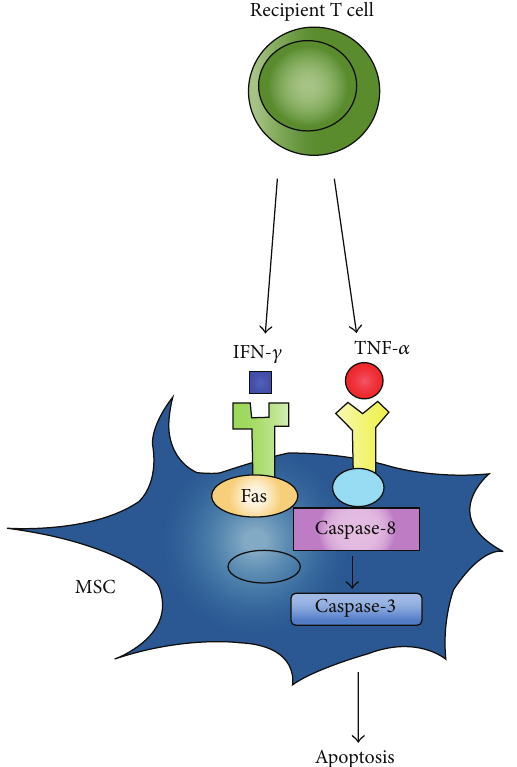
Figure 3: Immune cell modulation of MSCs. Combined action of IFN- 𝛾 and TNF- 𝛼 induces apoptosis of